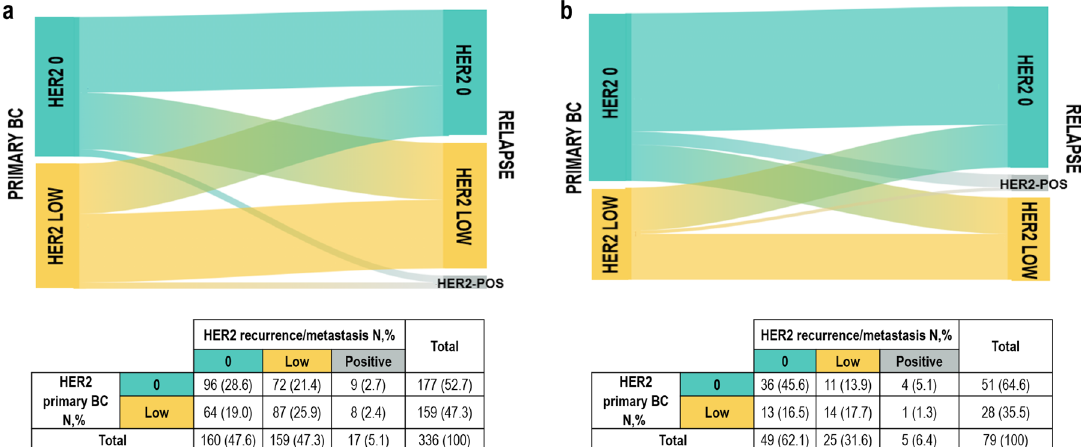
Fig. 3 HER2 expression evolution from primary BC to relapse according to breast cancer phenotype. a HR-positive/HER2-negative phenotype. b triple-negative phenotype. BC breast cancer, N number. Table 4. HER2 expression evolution from HER2-negative primary breast cancer to HER2-negative recurrent breast cancer according to breast cancer phenotype. HER2 expression on